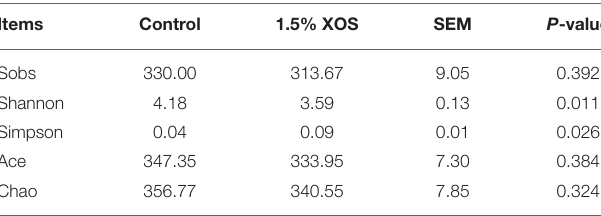
TABLE 7 | The effects of XOS supplementation on fecal microbial diversity of weaning piglets.